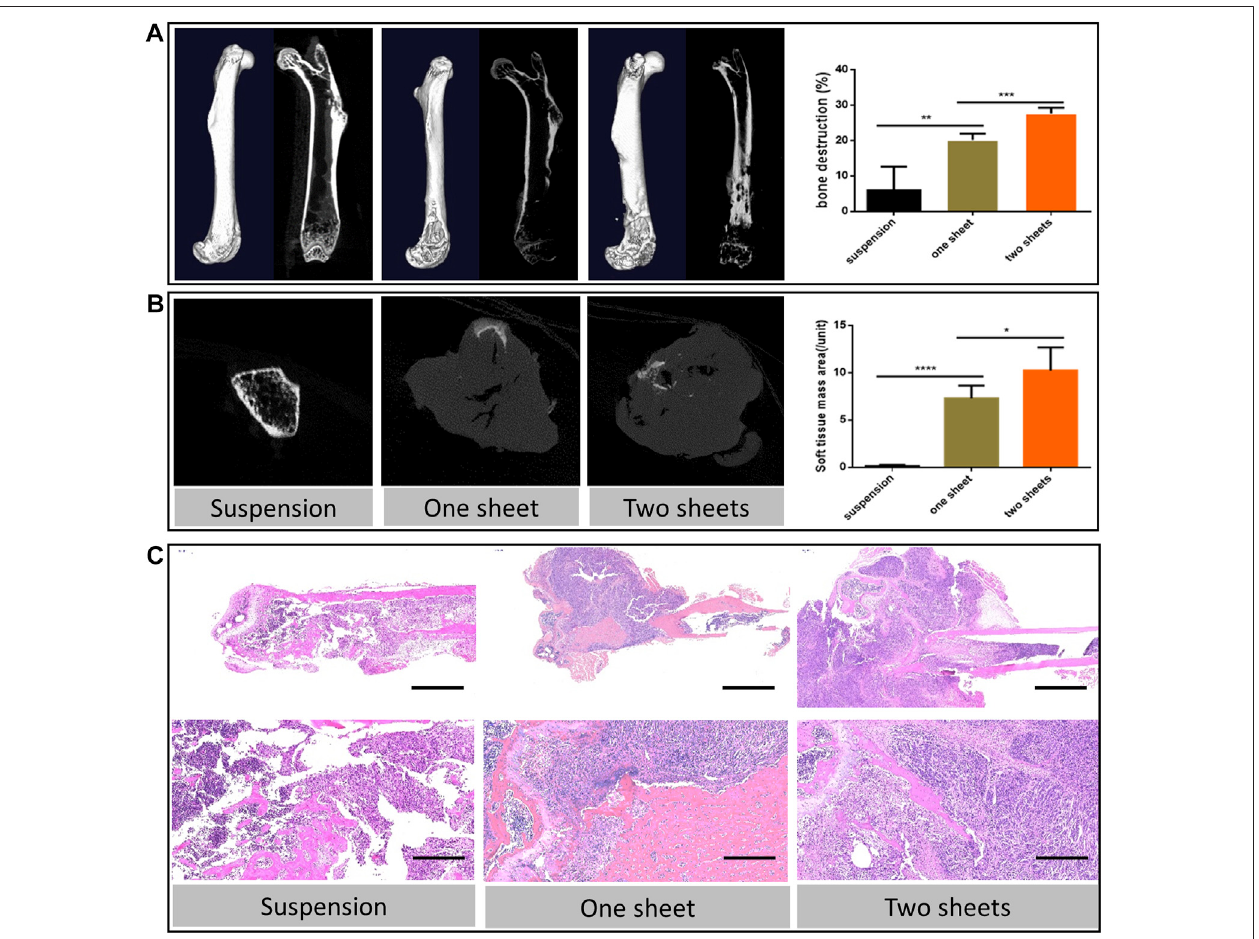
FIGURE 3 | Bone destruction characterization (A) 3D reconstruction and coronal images of micro-CT scan from representative femur lesions and corresponding statistics analysis of bone destruction percentage. (B) Transverse images of the representative soft tissue mass and corresponding statistics analysis. (C) Hematoxylin and eosin staining of the representative bone lesion. Scale bar in upper panel (cid:2) 2 mm; scale bar in lower panel (cid:2) 200 μ m.